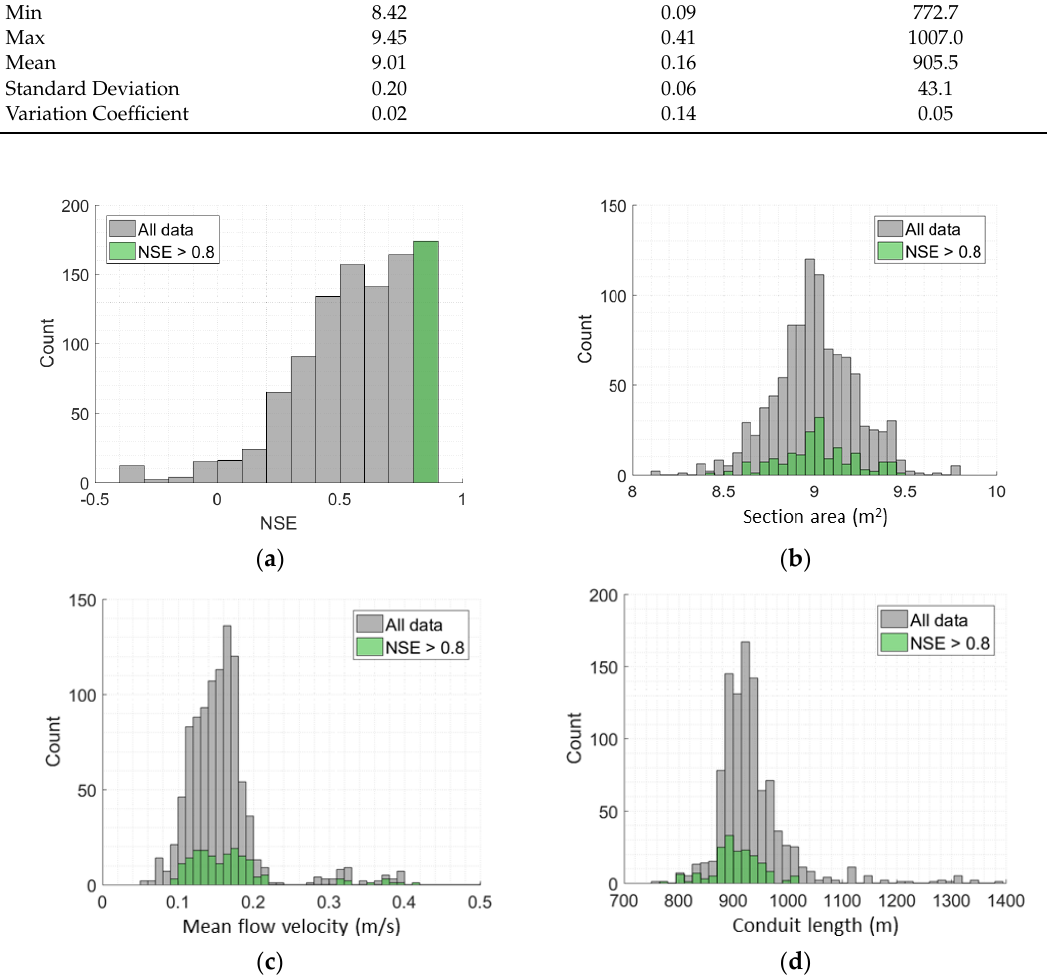
Figure 6. Histograms calculated over 1000 simulations on ( a ) NSE coefficient , ( b ) section area, ( c ) the mean flow velocity and ( d ) the conduit length. Grey bars are for all data and green bars represent the simulations providing an NSE superior to 0.8 between simulated RTD and observed RTD.